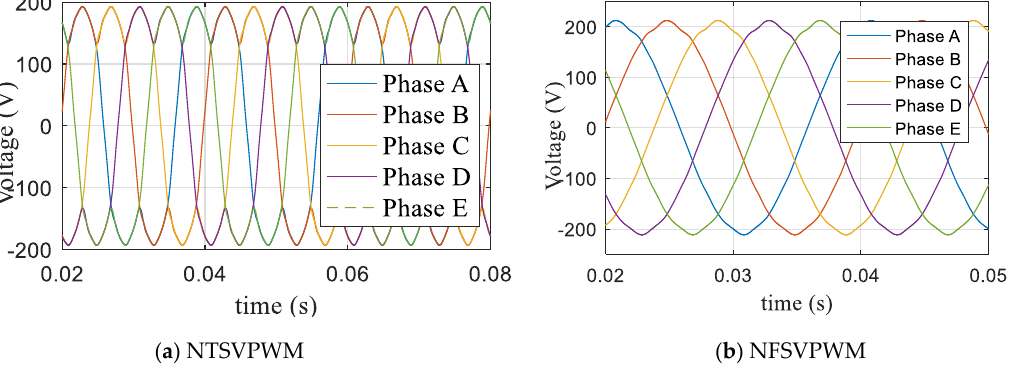
Figure 11. Voltage waveforms based on traditional algorithms.